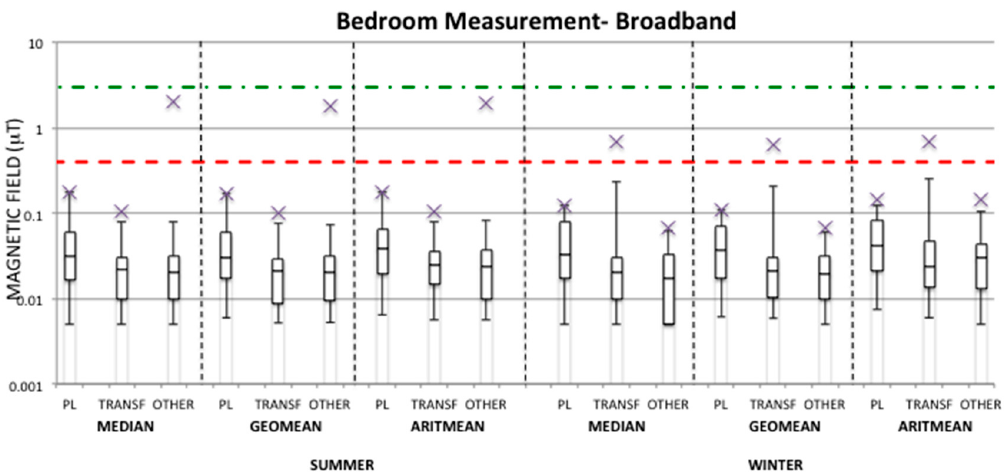
Figure 2. Distribution of the median, geometric mean, and arithmetic mean of the magnetic field ( μ T) in the broadband frequency range (40–800 Hz) indicated as a box-plot for bedroom measurements in both summer and winter periods for each group (PL, TRANSF, OTHER). The distribution values are indicated in Appendix Table A2.